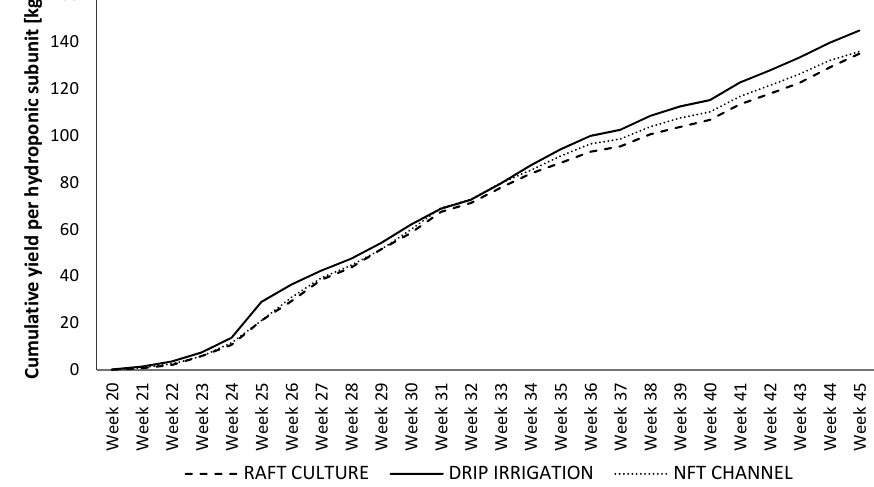
Figure A7. Average cumulative yield ( n = 3) per hydroponic subunit of all three quality categories from the “Wädenswil aquaponic system”, 2014.